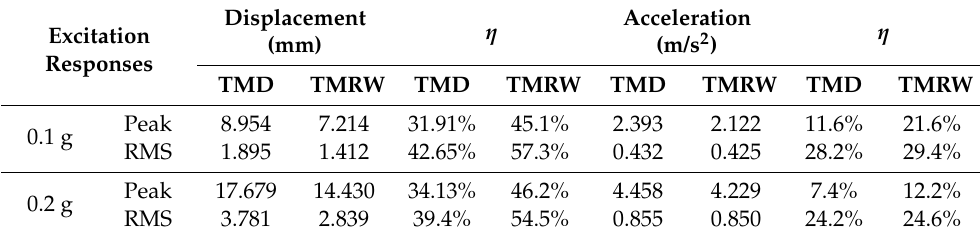
Table 3. Comparison of control effectiveness under Taft earthquake